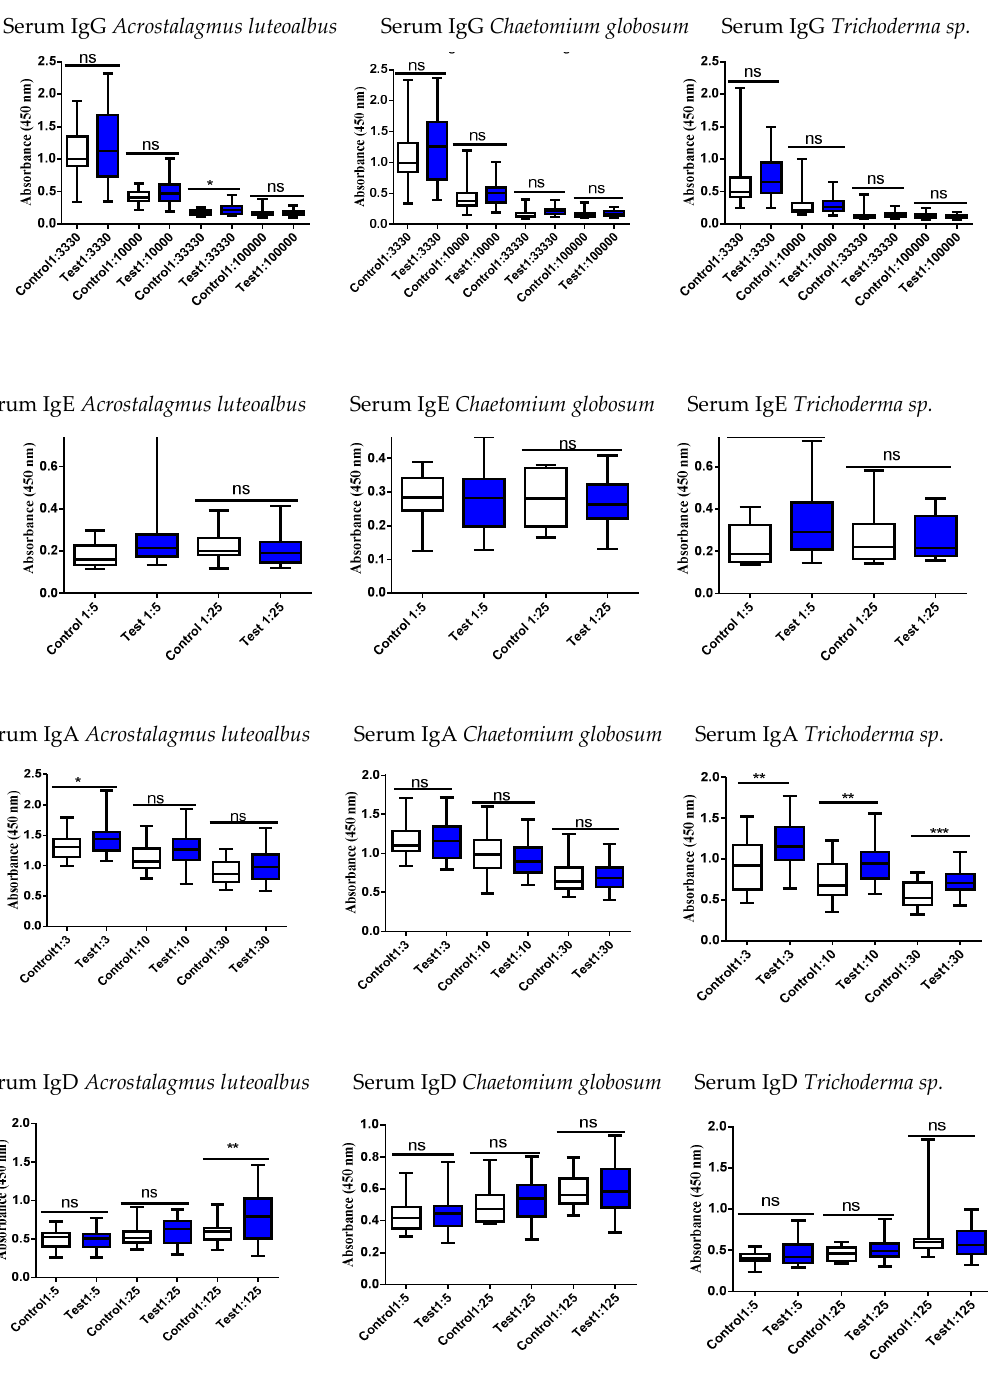
Figure 4. Serum Ig responses against Acrostalagmus luteoalbus, Chaetomium globosum and Trichoderma sp. (=atroviride 14/AM). Serum levels of IgE and IgA against A. luteoalbus and Trichoderma sp. were increased in exposed subjects, but the results were otherwise unable to differentiate between exposed and control subjects. Note that there is no difference between subjects in all C. globosum Ig results. Although this highly toxic isolate of C. globosum MTAV35 used was not from these buildings, it was used as a reference strain. There was an abundance of C. globosum strains in the target building, but these were not studied [20,21]. Boxplots indicate median values with 95% confidence intervals; statistically significant * p < 0.05, ** p < 0.01, *** p < 0.001 and **** p < 0.0001 when the study persons were compared to controls. Ns =